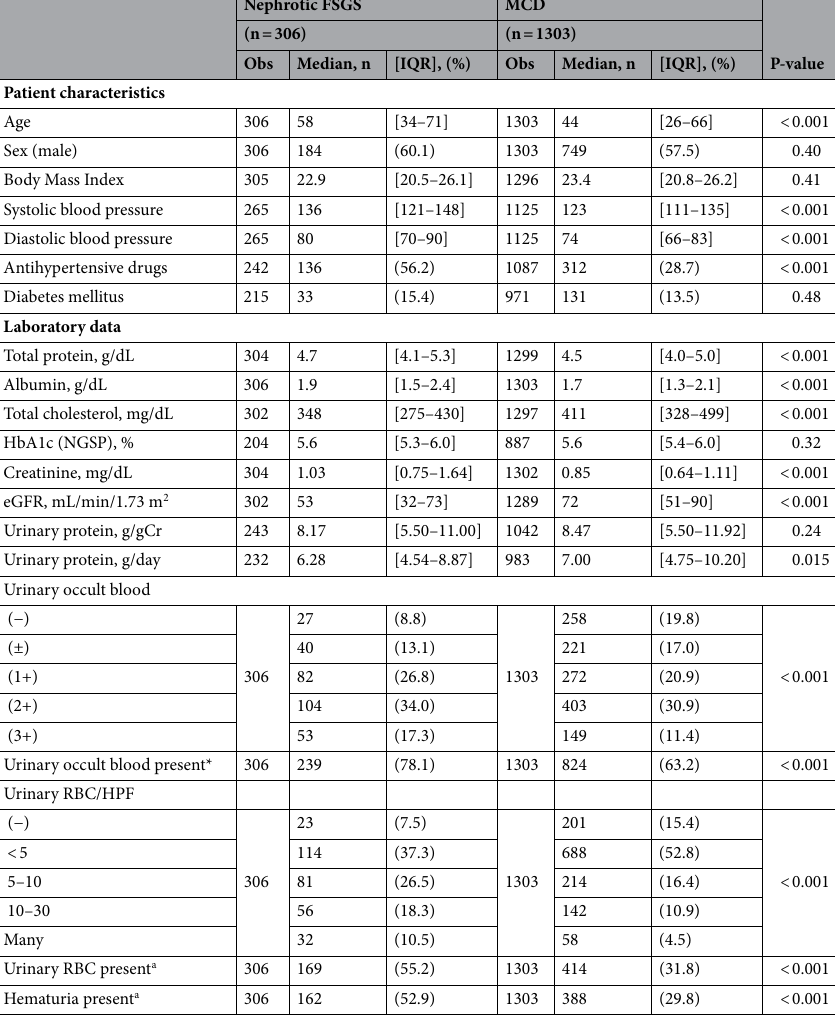
Table 2. Comparison between nephrotic FSGS and MCD cases. FSGS focal segmental glomerulosclerosis, MCD minimal change disease, eGFR estimated glomerular filtration rate, RBC red blood cell, HPF high powered field. a Definition: Urinary occult blood present, (1+), (2+), (3+) on dipstick; Urinary RBC present, ≥ 5/HPF in urine sediment; Hematuria present, (1+), (2+), (3+) on dipstick and ≥ 5/HPF in sediment.